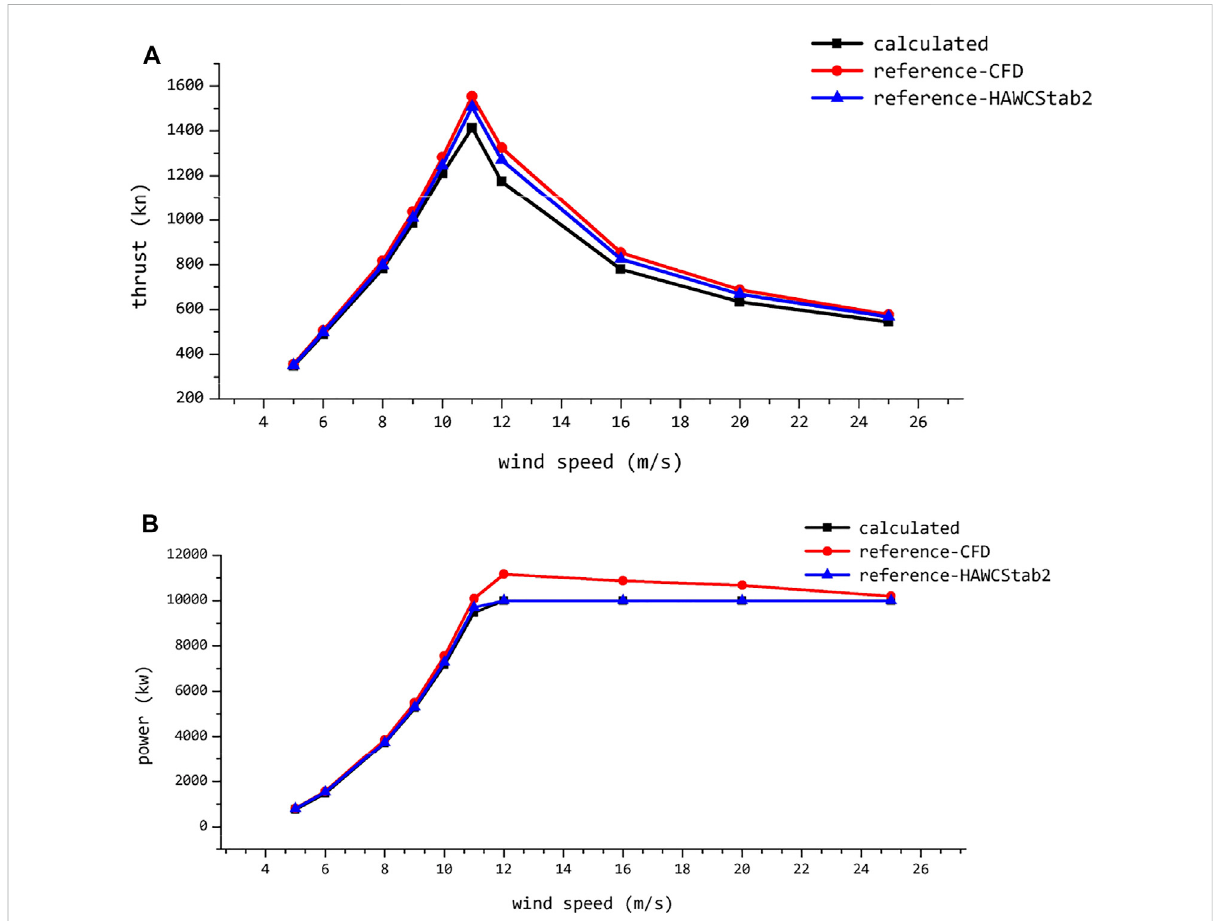
FIGURE 3 The thrust and power under different wind speeds: (A) thrust; (B)